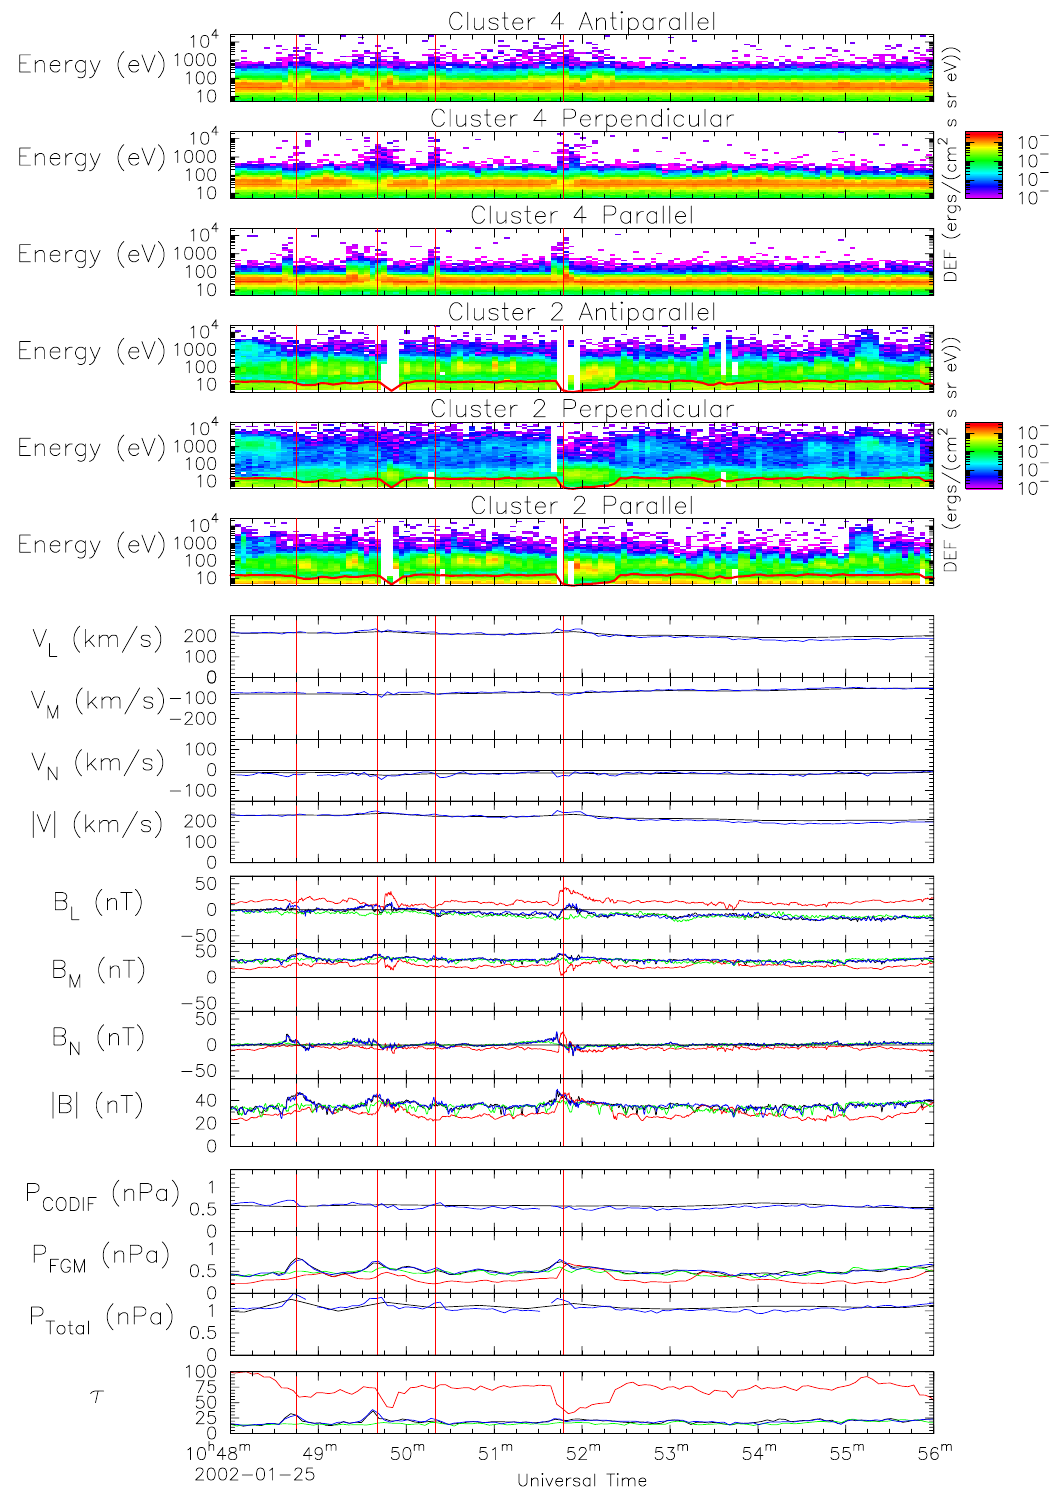
Fig. 8. Plasma and magnetic field data from the 10:52 UT event. This figure follows the same layout as Fig. 7, except that spectrograms for Clusters 4 and 2 are shown (Cluster 4 data use on-board pitch angle binning; Cluster 2 data have been rebinned on the ground). Cluster 3 moments are not shown as the lack of dead-time correction reduces their reliability in the magnetosheath. Four magnetosheath FTEs are identified by vertical red